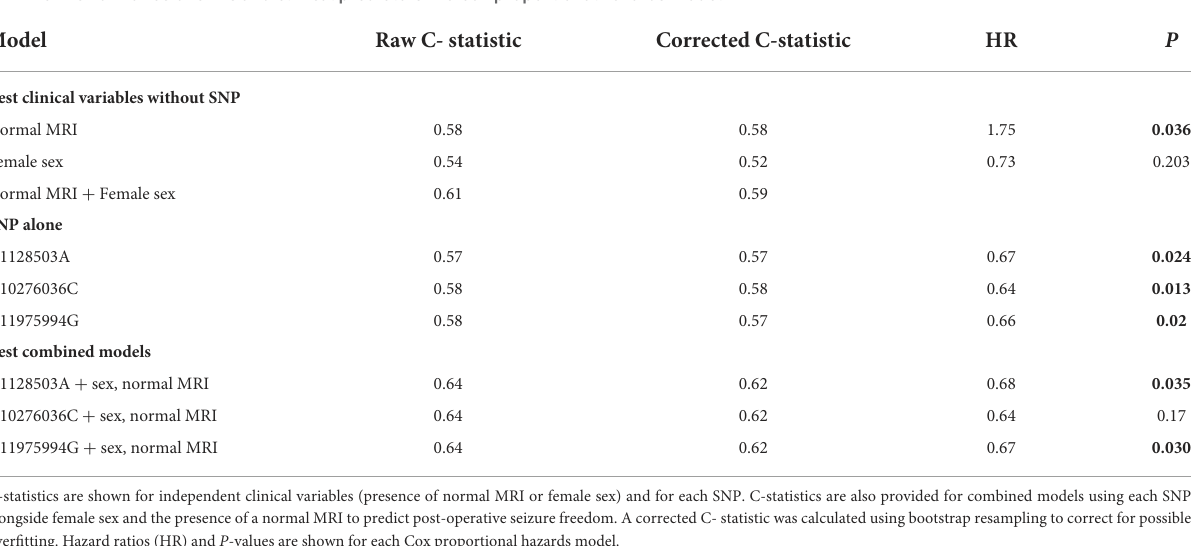
TABLE 3 Performance of SNPs and clinical predictors in a cox proportional hazards model.